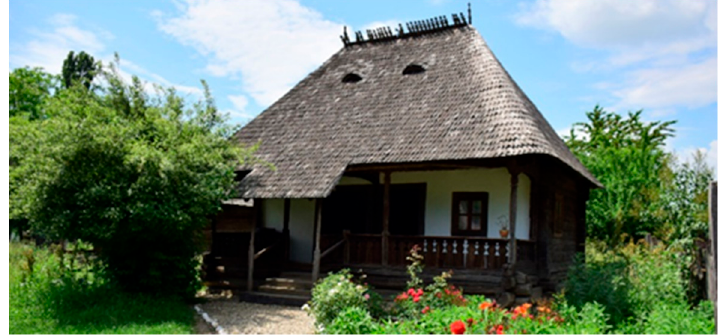
Figure 1. Example of a Romanian traditional building